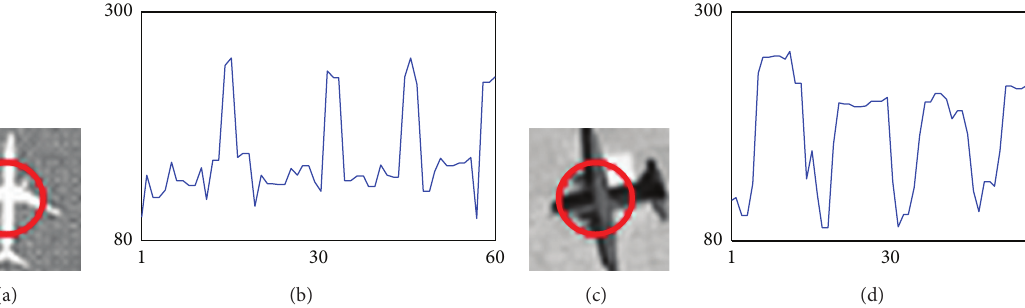
Figure 2: Illustration of the aircraft regular patterns. (a) Bright aircraft (32 × 32 pixels); (b) regular pattern of the bright aircraft; (c) dark aircraft (32 × 32 pixels); (d) regular pattern of the dark aircraft. The intensities along the red circle will change regularly from darkness to brightness and will repeat four